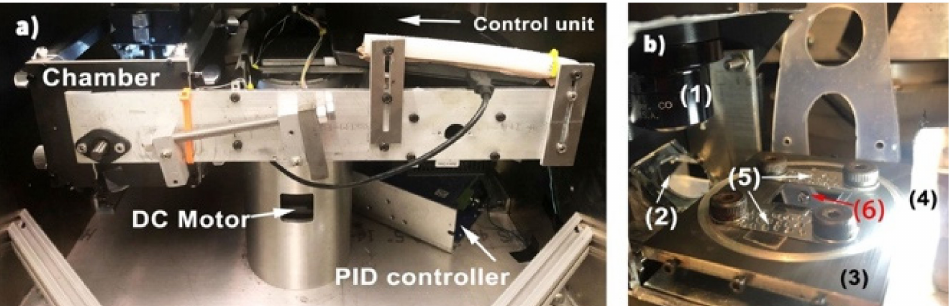
Figure 30. Optical images of the ( a ) centrifugal Adhesion Balance (CAB); and ( b ) individual compo- nents inside the instrument including the (1) camera lens, (2) mirrors (45 ◦ tilted), (3) sample stage, (4) light source, (5) satellite drops, and (6) central drop (Reprinted with permission from [206]. Copyright {2019} American Chemical